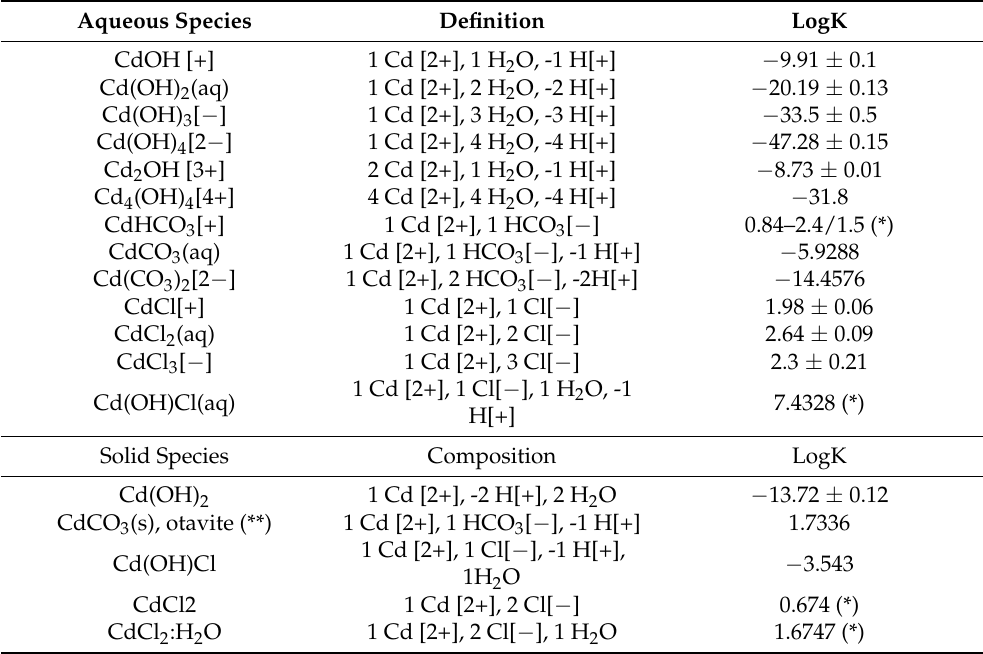
Table 1. Thermodynamic constants for Cd, taken from [37]. Data with (*) had a large uncertainty or values were not specifically suggested in [37]; thus, the available data in the EQ3/6 database were used. Aqueous Species Definition LogK CdOH [+] 1 Cd [2+], 1 H 2 O, -1 H[+] − 9.91 ± 0.1